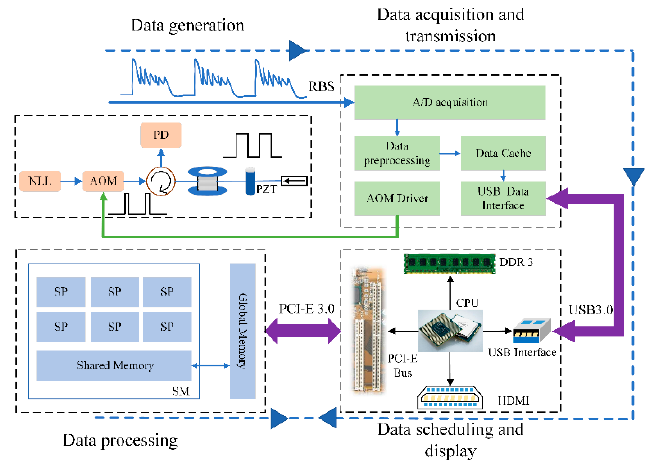
Figure 3. Data flow and storage analysis.